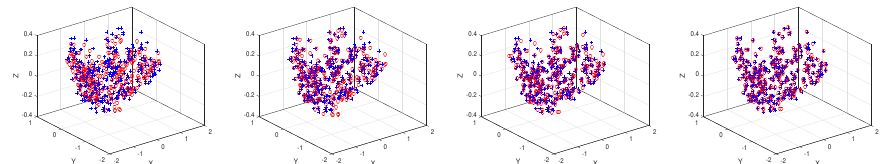
Figure 9. Registration results obtained from the application of pair-wise rivals on a specific example generated from 3D COPD data. Initial unregistered point sets (first column) and the results of CPD (second column), CPD-GL (third column), and SCGF (fourth